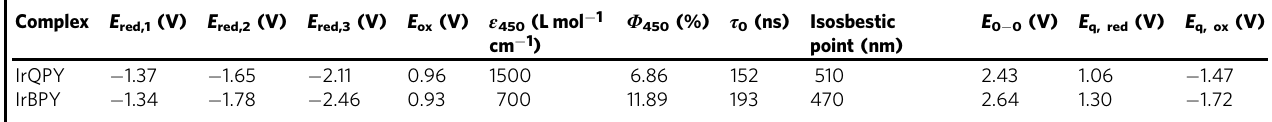
Table 1 Redox properties and photophysical properties of Ir